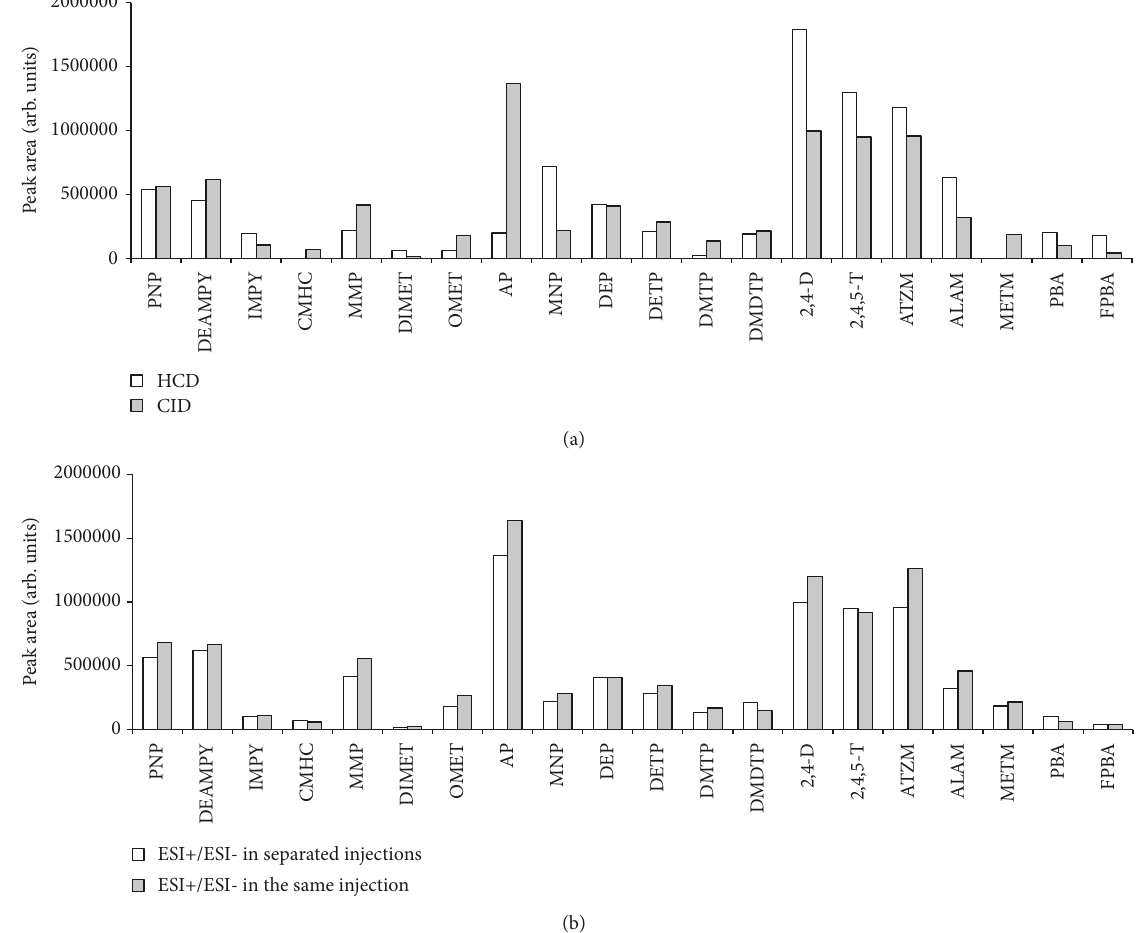
Figure 2: (a) Comparison between responses (peak area) of fragments obtained using CID (40 eV) and HCD (20eV). (b) Comparison betweenCIDfragmentation(40 eV)usingthepolarityswitchingfunction(ESI + andESI − )inthesameinjectionandintwoseparateinjections. Acquisition conditions: R= 25,000 FWHM and external mass